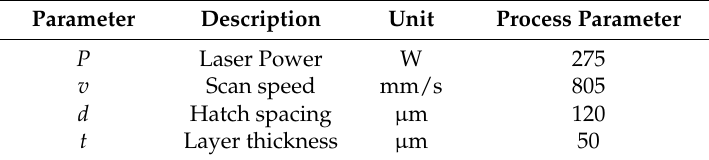
Table 2. Overview of energy-relevant process parameters used to build all samples, SLM process.